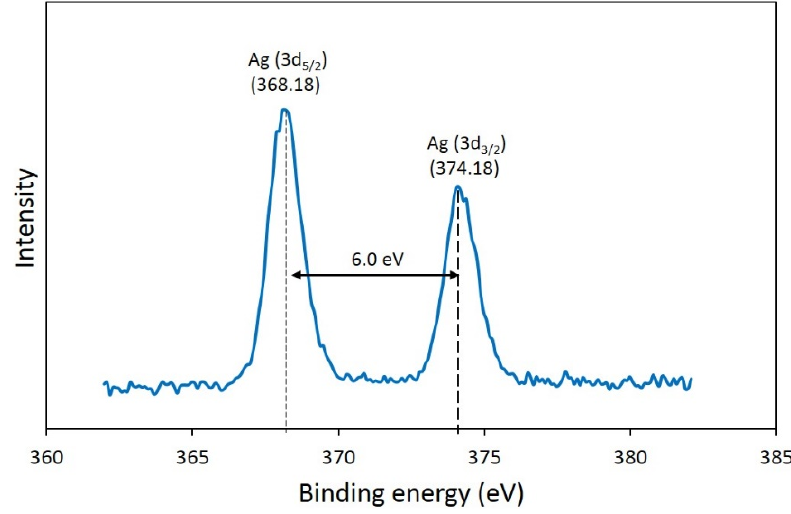
Figure 6. X-ray diffraction (XRD) spectra of ( a ) SS treated silk fabrics and ( b ) SS-AgNP treated Figure 6. X ‐ ray diffraction (XRD) spectra of ( a ) SS treated silk fabrics and ( b ) SS ‐ AgNP treated silk silk fabrics. Coatings 2017 , 7 , 145 fabrics.